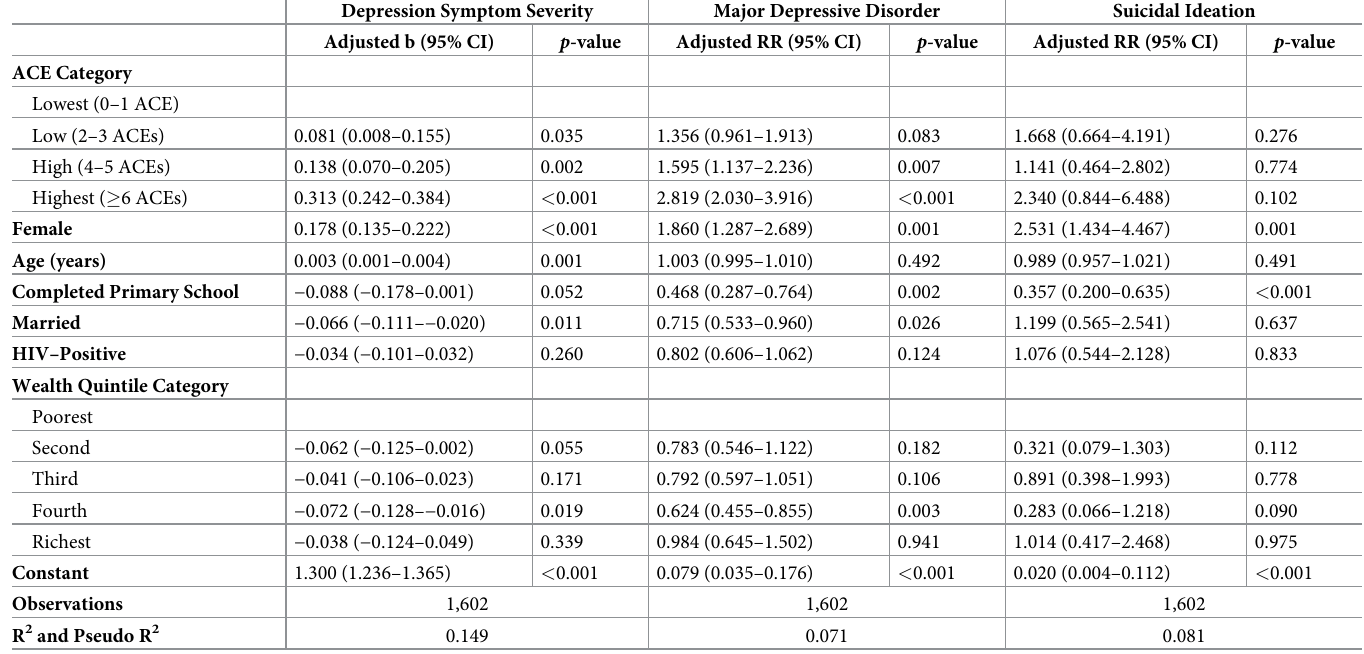
Table 4. Adjusted linear and Poisson regression models estimating associations between ACE category and depression symptom severity, major depressive disor- der, and suicidal